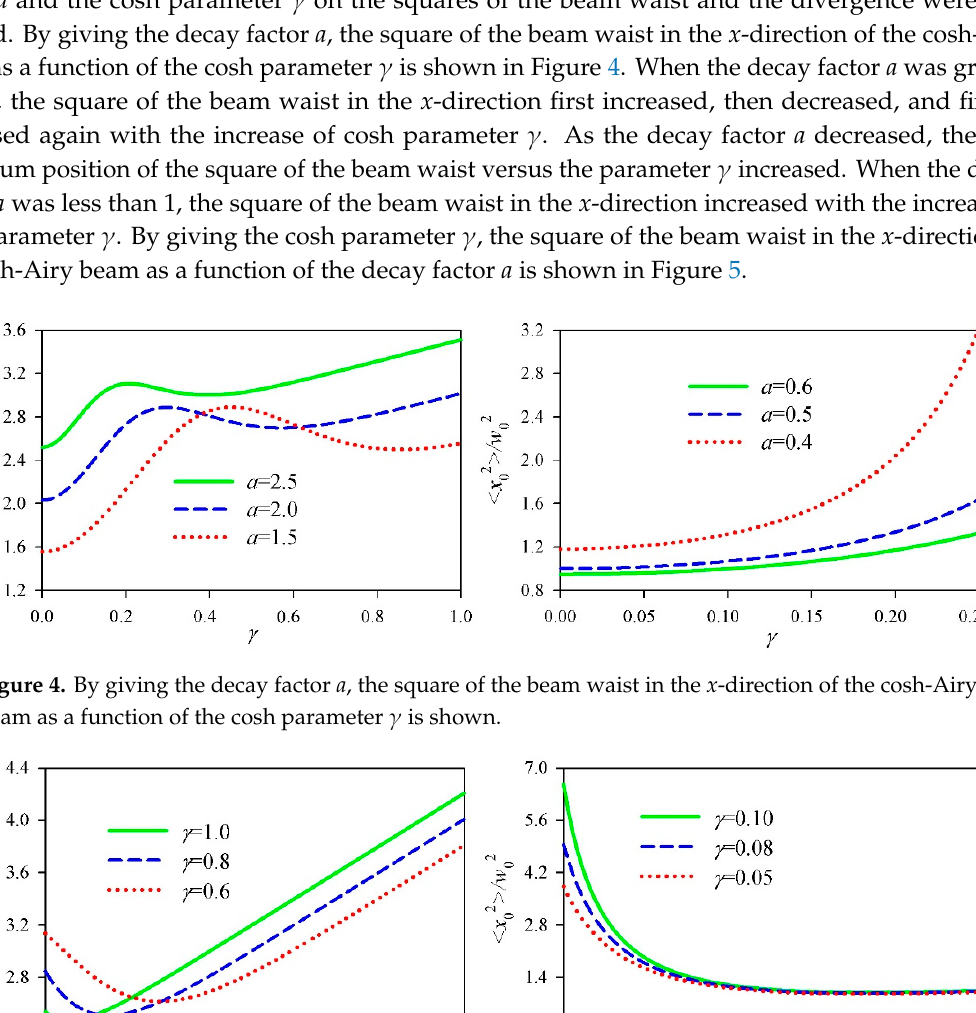
Figure 6. By giving the decay factor a , the square of the divergence in the x- direction of the cosh-Airy beam as a function of the cosh parameter γ is shown.